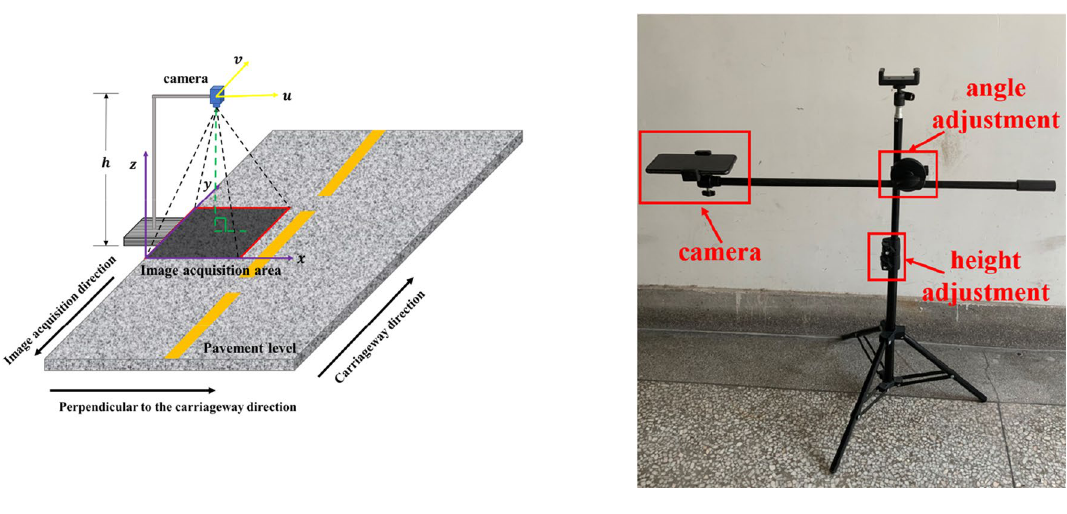
Figure 10. Field collection